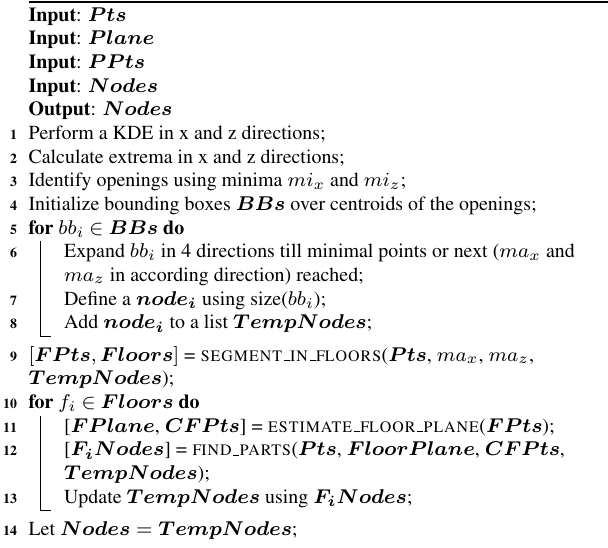
Figure 5: Local KDE in the neighbourhood of an opening in the main plane of the fac¸ade from figure 4. The maxima are incorpo- rated for the identification of shape parameters of a window. Algorithm 2: FIND PARTS – KDE-based identification of fac¸ade